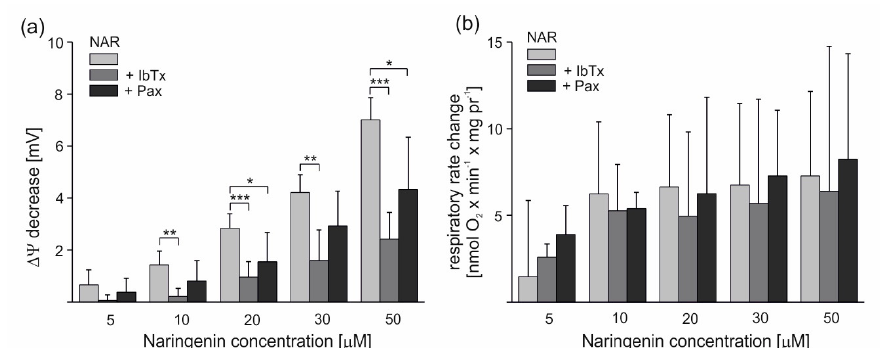
Figure 3. Naringenin-induced changes in the ∆ Ψ and respiratory rate of isolated endothelial mitochondria under nonphosphorylating conditions. The effect of different naringenin concentrations on ∆ Ψ ( a ) and respiratory rate change ( b ) in the absence or presence of mitoBK Ca channel inhibitors (2 µM iberiotoxin (+IbTx) or 0.3 mM paxilline (+Pax)). The data represent at least five different mitochondrial preparations and are expressed as the means ± SD. *** p < 0.001, ** p < 0.01, * p < 0.05.